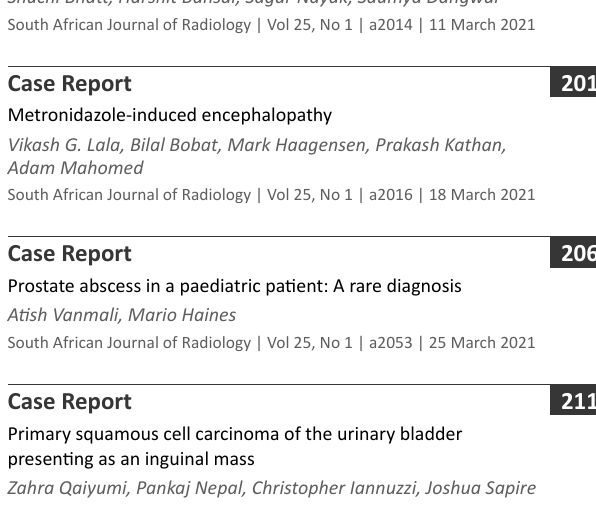
Infrapatellar plica injury: Magnetic resonance imaging review of a